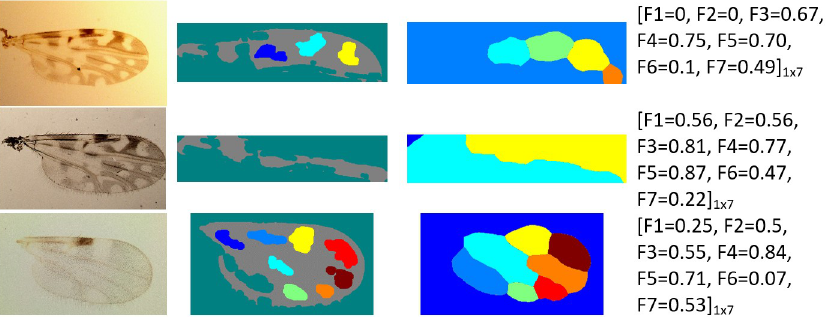
Fig 8. Examples of unsuccessful performance of the proposed method on different species samples. From left to right column: original wing image, particle detection, segmentation of zones of interest through the watershed method, and the final feature vector output